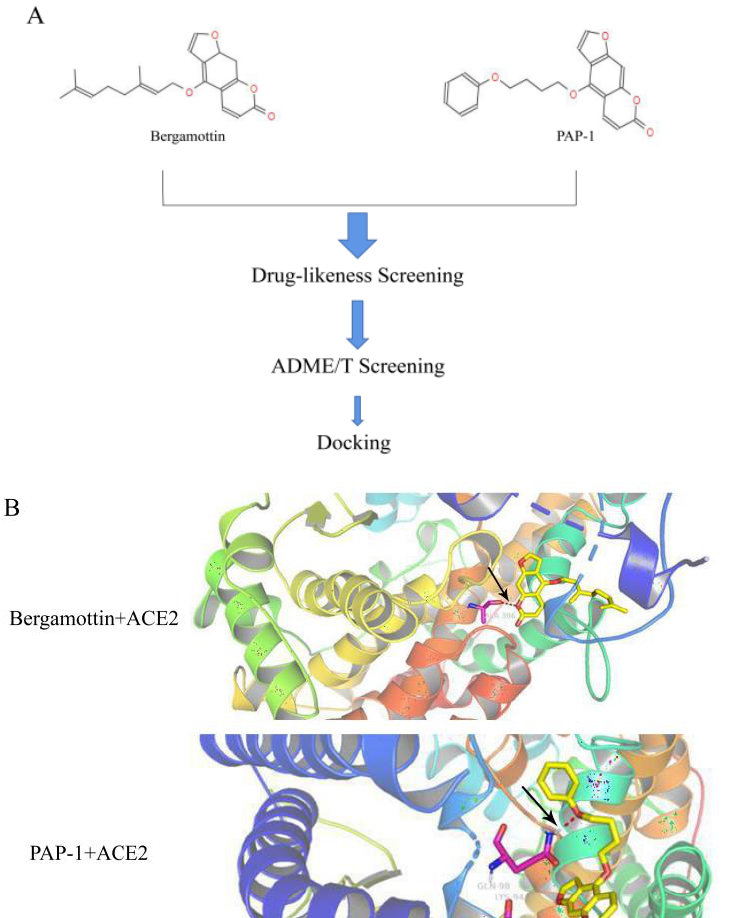
Table 3. The interaction between compounds and RBD Spike S proteins.